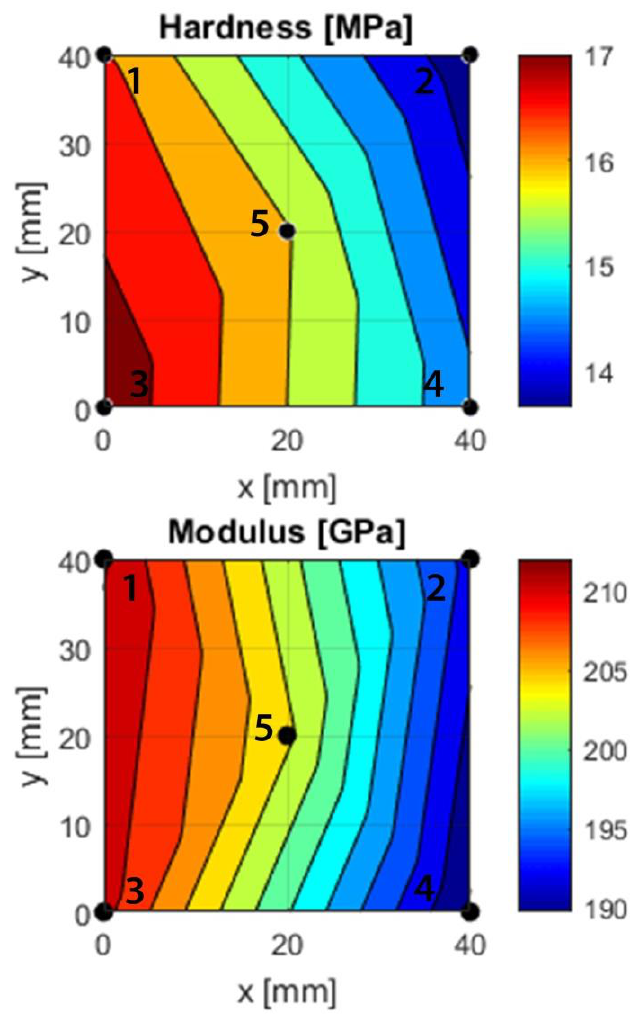
Figure 7. Hardness and modulus gradients based on nanoindentation measurements at points 1–5. A piecewise linear interpolation between sets of three points was used to create the fit. The modulus relates to the Young’s modulus by (1 − ν 2 ).